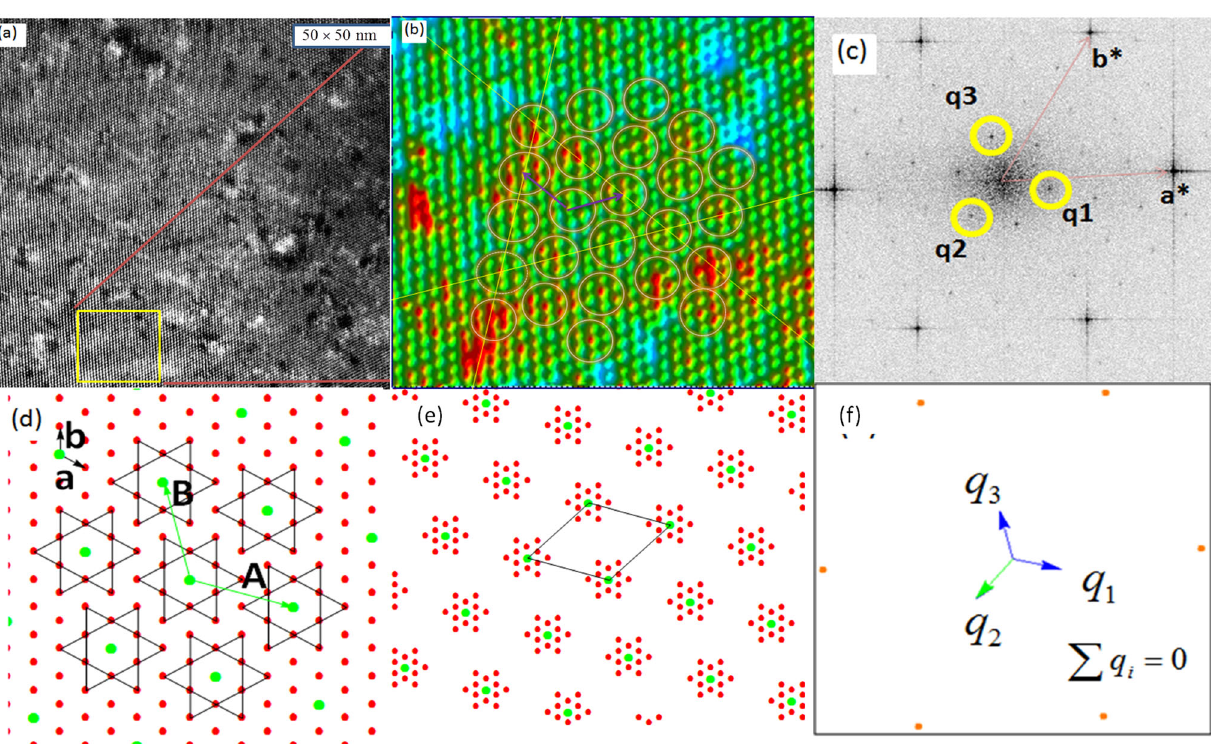
Fig. 3 Tri-layer 1T-TaS 2 a STEM image of tri-layer 1T-TaS 2 at room temperature. Surprisingly, super-lattices of C-CDW are seen throughout the entire sample and are particularly obvious in the yellow frame in the lower left of this image. The super-lattices form hexagonal structures as seen in Fig. 3(e). b Top- view of the three-dimensional intensity plot of the area in the yellow frame in Fig. 3(a). Higher scattering magnitudes are shown in red . Brown circles show super-lattices. Purple vectors are super-lattice vectors ( A , B ). c Fourier transformed image (FTI) of Fig. 3(a). q q q 1 , 2 , 3 are C-CDW satellites. Satellite peaks are clearly present. This is due to an overlap of different diffraction orders. tantalum layer of 1T-TaS 2 . 25 a , b are basic lattice vectors. The red points are Ta atoms and the green points are Ta atoms forming the center of the star-like super-lattice. A , B are super-lattice vectors in C-CDW ( A = 4 a + b , B = - a + 3 b , | A | = | B | = √ 13 | a | ). e A sketch of super-lattices in C- CDW state. 25 The super-lattices form a new hexagonal lattice with basic vectors A and B . This is called a √ 13 × √ 13 structure. f Satellite patterns of the tri-layer sample. The orange points are Bragg peaks of the lattice. The blue arrows are nesting vectors. The green arrow is - q 1 - q 2 , which overlaps with q 3 , so the sum of q vectors is